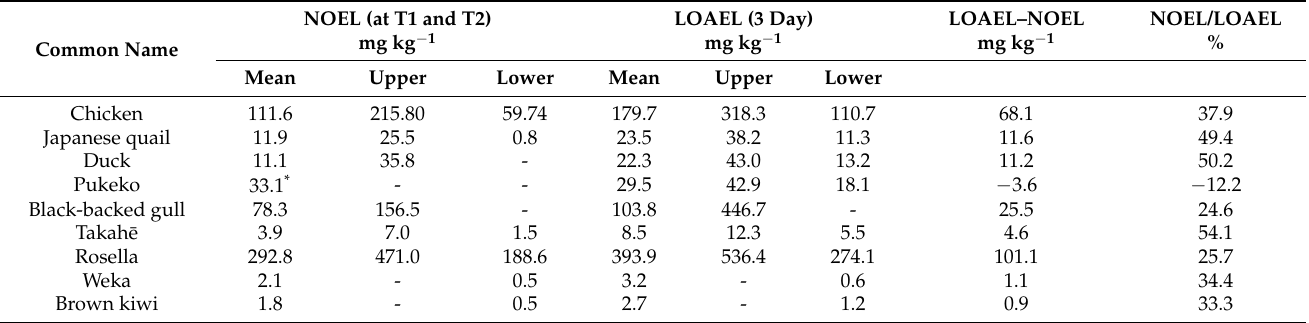
Table 7. No Observable Effect Level (NOEL) based upon the PAPP doses (mg kg − 1 ) associated with an MAI 1 SD from the T0 mean. Lowest Observed Adverse Effect Level (LOAEL) estimates were based upon the PAPP dose that caused a shift in any blood value 2 SDs from the T0 mean over the 3-day monitoring period. Estimates are provided with 95% confidence estimates. The difference between the levels in mg kg − 1 (LOAEL–NOEL) and their ratio (NOEL/LOAEL) is presented for